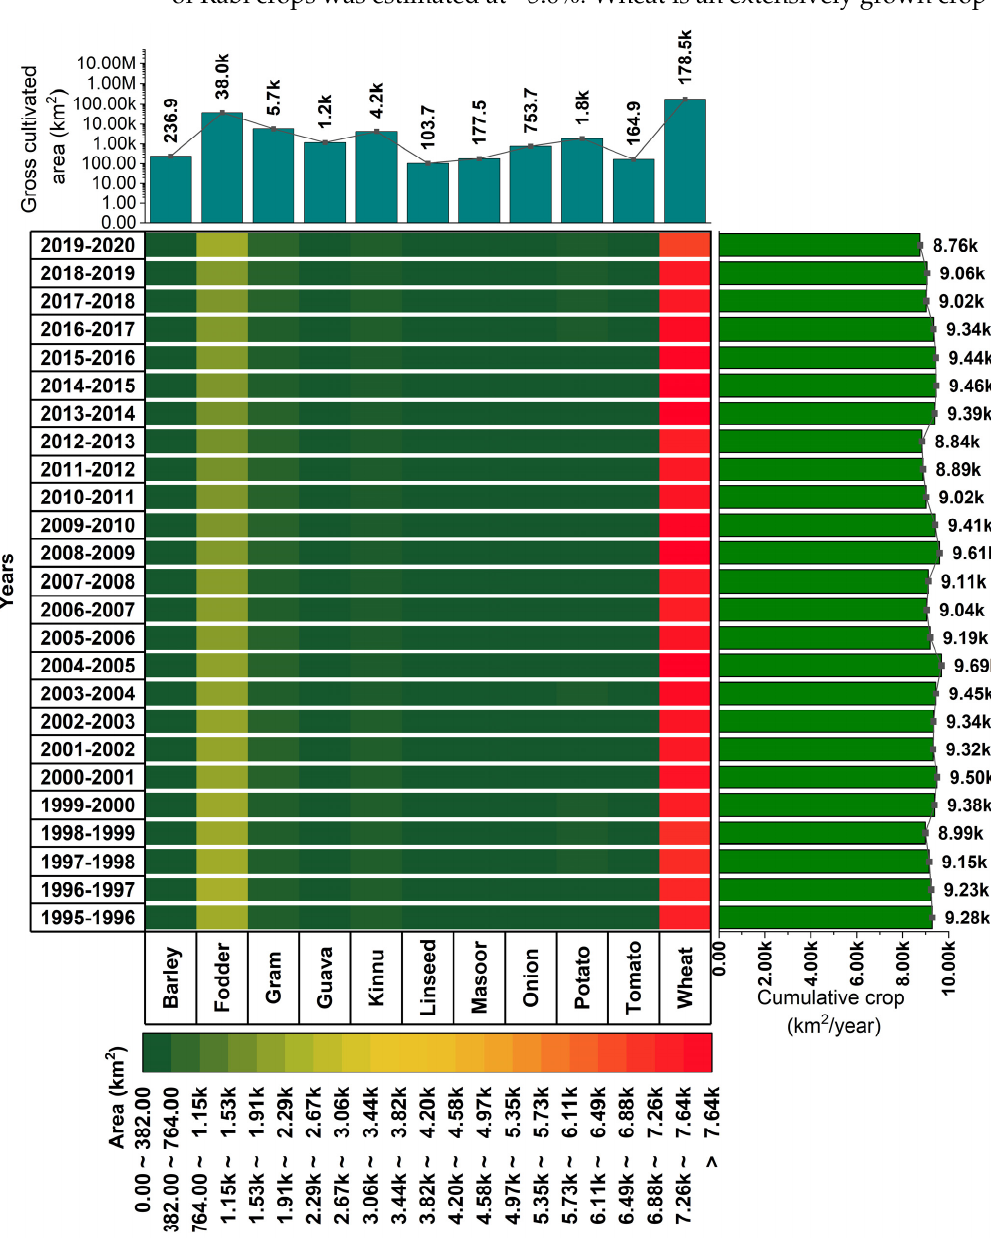
Figure 5. Shift in cropping pattern and cultivated area from 1995 to 2020 in the Rabi season.